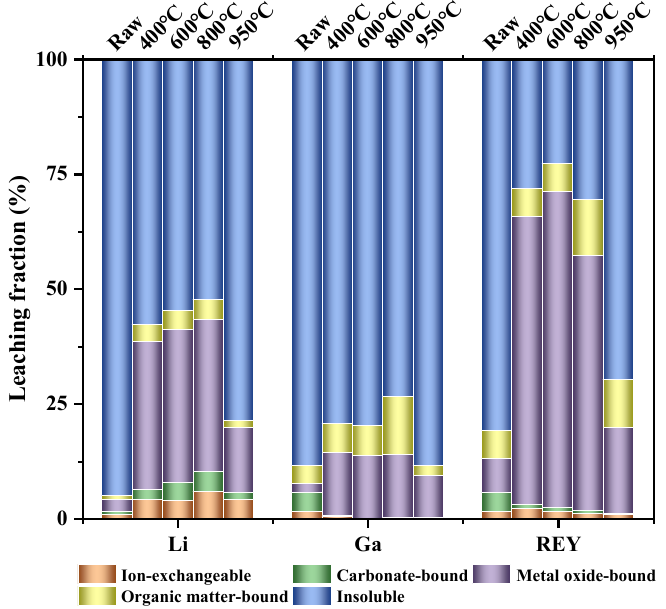
Figure 7. Effects of calcination on the recovery of Li, Ga, and REY from coal gangue.